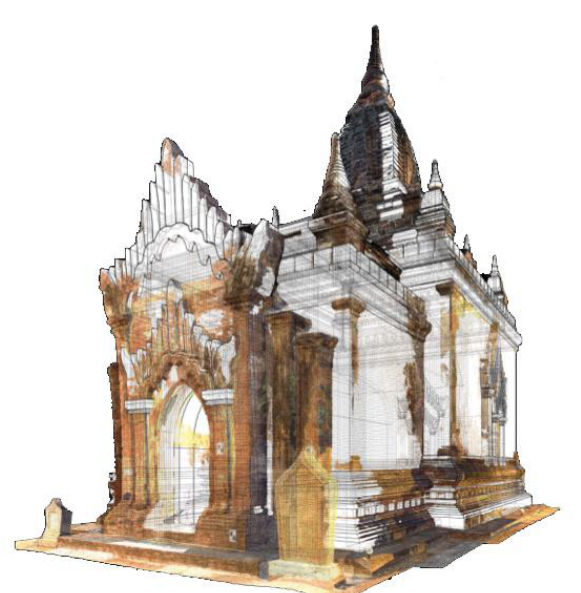
Figure 6. Condition assessment of Loka Hteik Pan (Mezzino et al,. 2017).